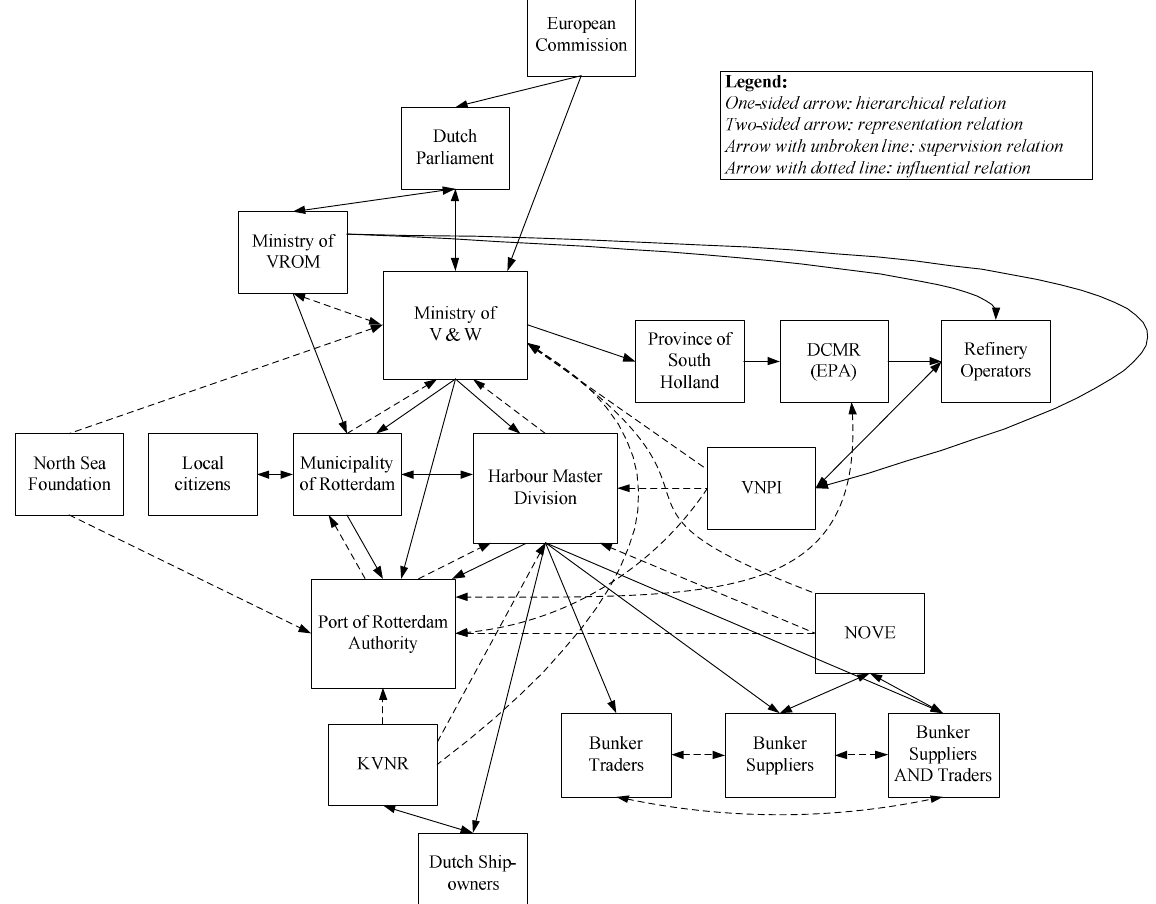
Figure 4. Relations between actors in